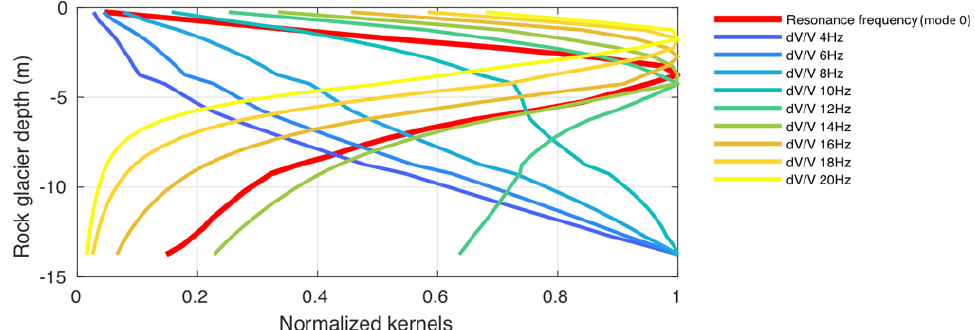
Figure 12. Example of (normalized) depth sensitivity kernels of the two passive seismic methods for the Laurichard (C00 seismometer) rock glacier model. The red curve corresponds to the modal analysis (resonance frequency of the first vibrating mode). The other curves correspond to the ambient noise correlation (relative change in the Rayleigh wave velocity d V/V , depending on the frequency, shown by the other colors). At high frequencies ( > 14Hz), d V/V is most sensitive at shallower depths than the resonance frequency of the first mode, whereas at low frequencies ( < 14Hz), d V/V is most sensitive at deeper depths than resonance